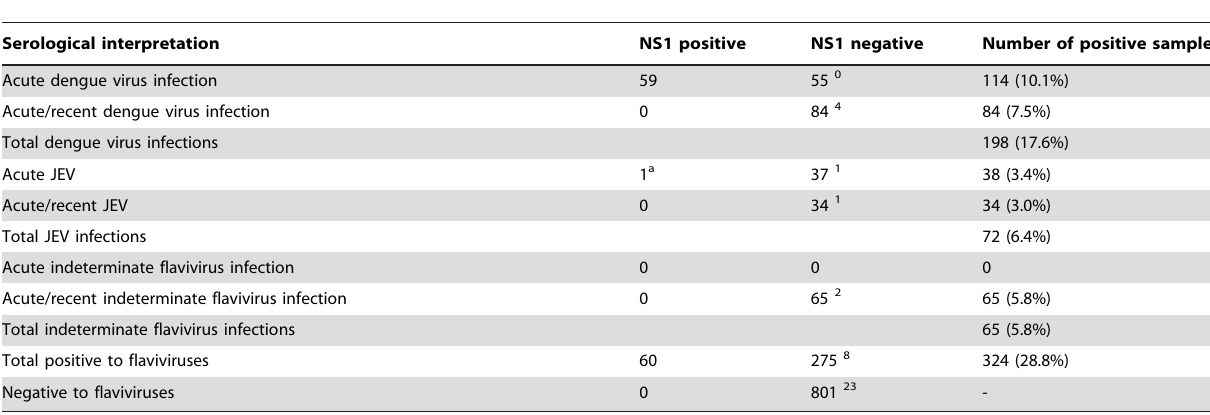
Table 7. Serological results for flaviviruses for episodes in children of 60 days or older ( n = 1125).